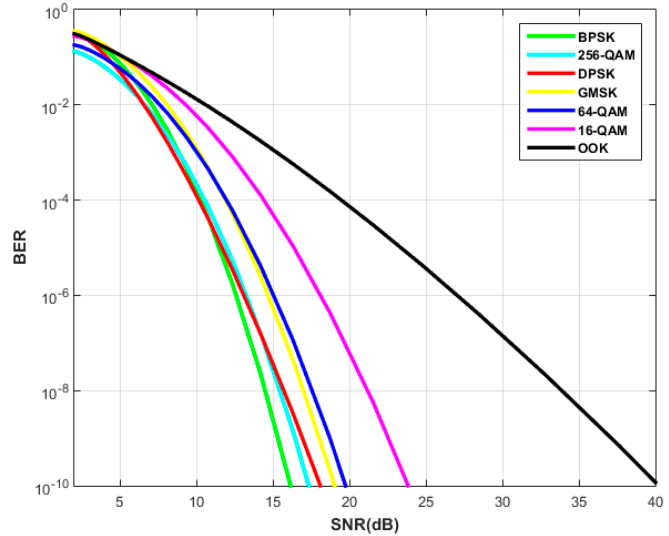
Figure 5. BER performance of di ff erent modulation formats without SDRT in a moderate turbulence